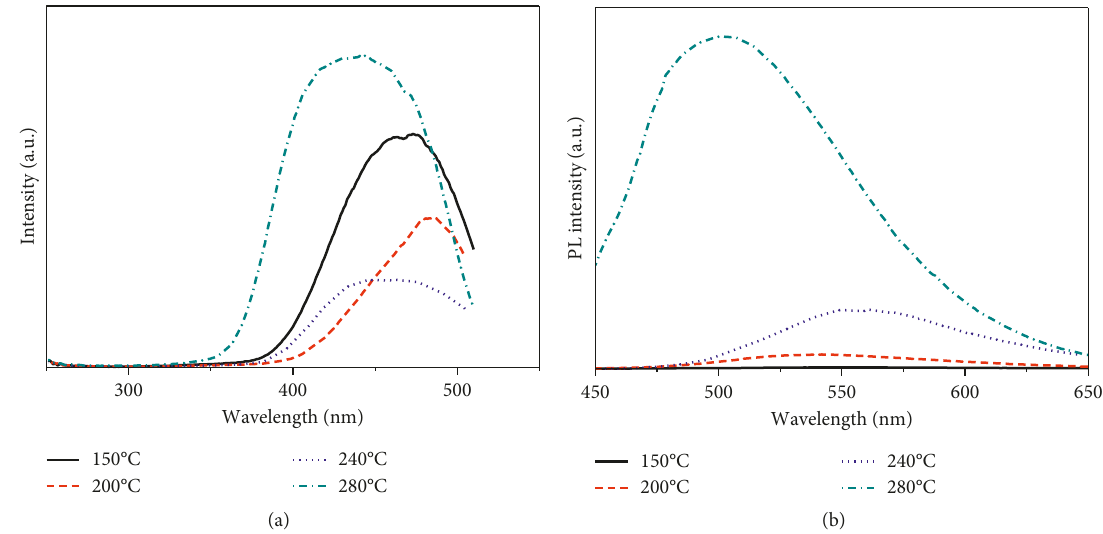
Figure 6: Optical properties of C-dots. (a) PLE spectra and (b) PL spectra of C-dots synthesized at different